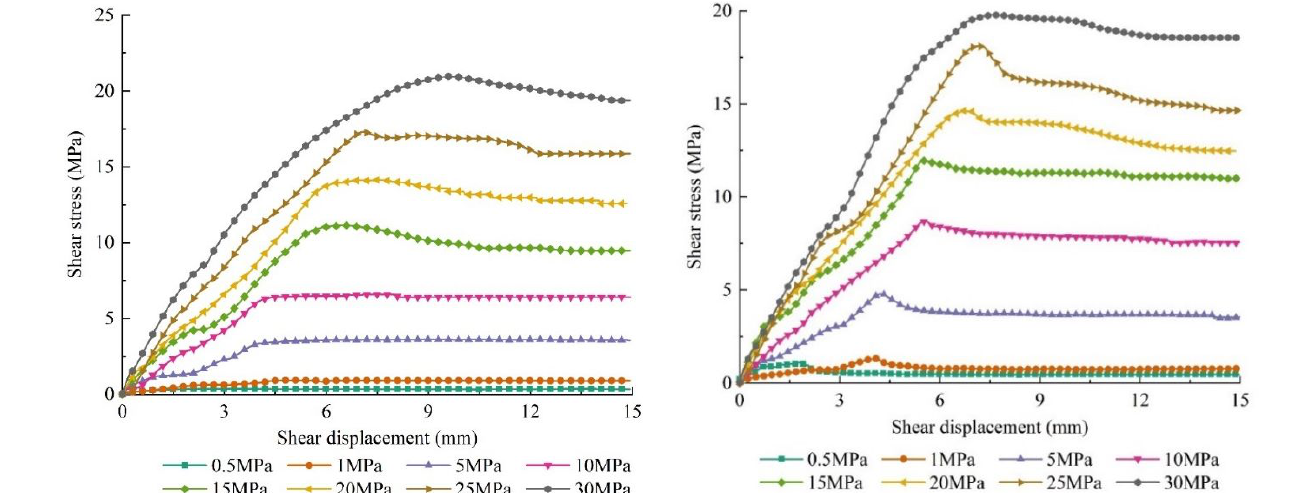
Figure 8: Shear stress-displacement curve of flat rock joint under different normal stresses